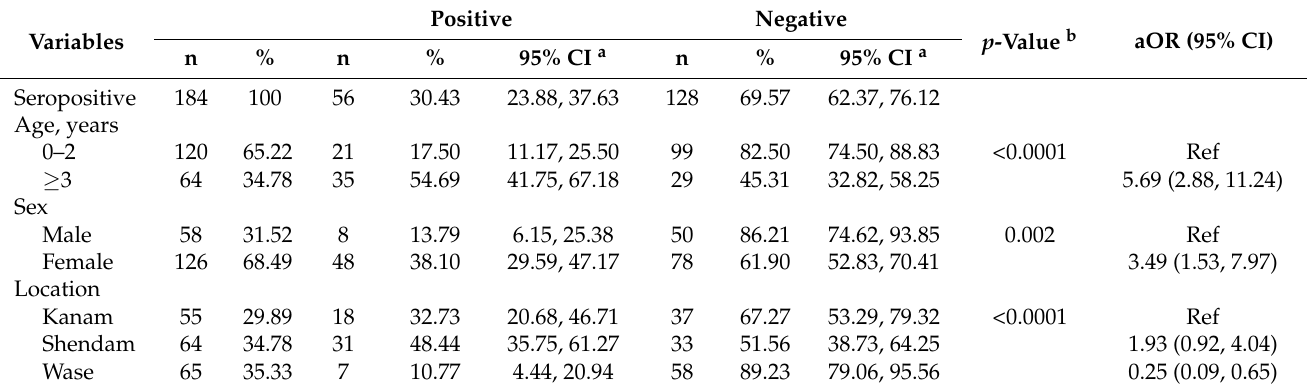
Table 1. Distribution of CCHFV antibodies in cattle in Plateau State,